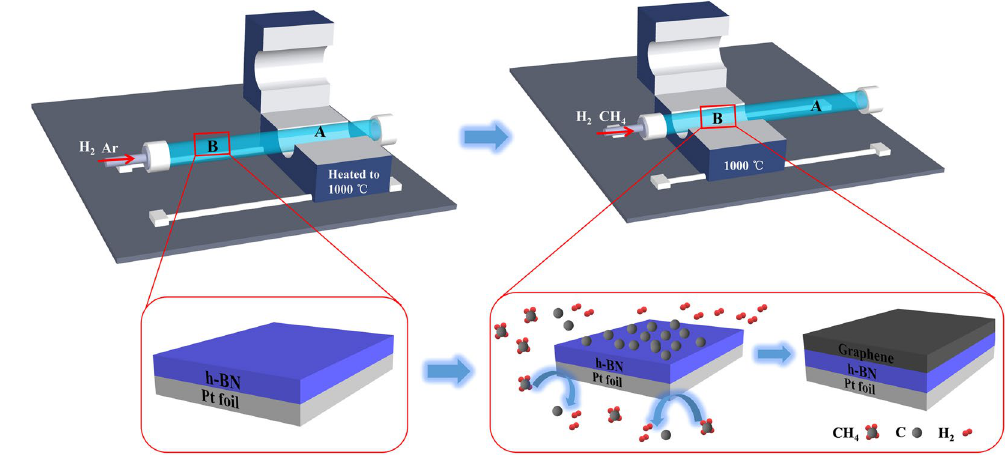
Figure 1. Schematic of the thermal CVD system for growing single-layer graphene on a h-BN/Pt foil.